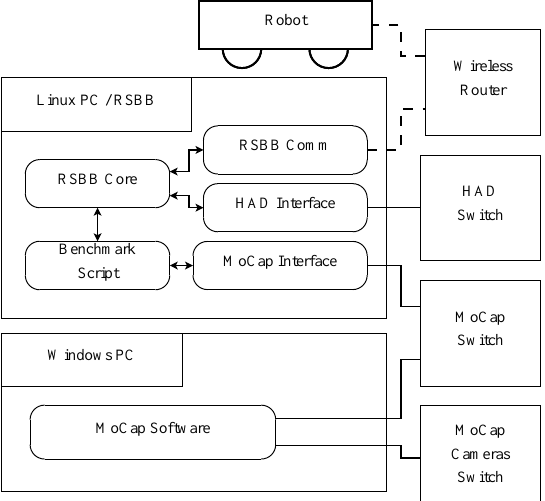
Figure 9. RSBB machine and its network diagram. Solid lines indicate wired connection, while dashed lines indicate wireless connection.